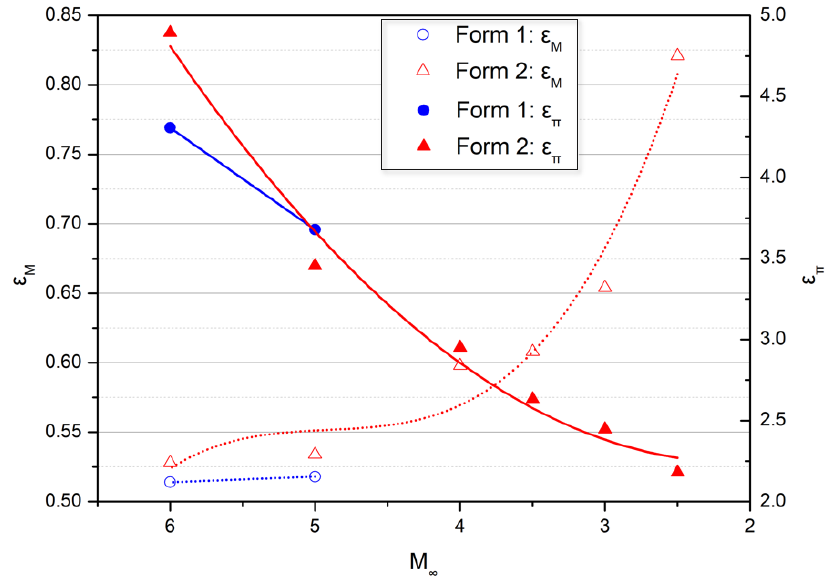
Figure 10. Compression and deceleration ratios in a wide Mach range.